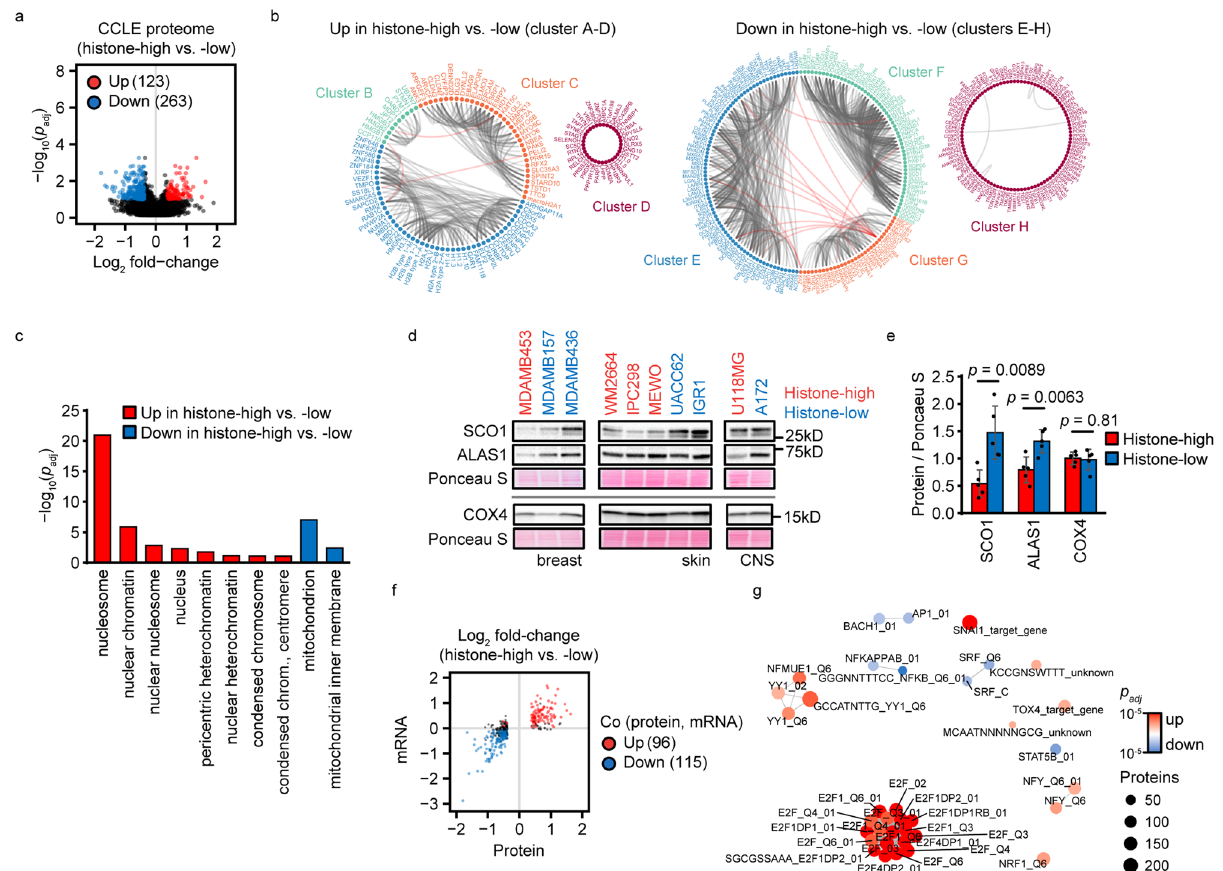
Fig. 4 Histone density-associated molecular signatures. a , b Signi fi cantly different proteins in histone-high ( N = 37) vs. -low ( N = 31) cells. a Proteins were tested for signi fi cantly different levels in histone-high vs. low cells using the R package maanova (FDR < 0.1, fold-change >1.3). Signi fi cant hits are shown in the Volcano plot by color coding. b Proteins with signi fi cantly higher or lower expression in histone-high cells were clustered by co-expression across cancer cell lines, and clusters were visualized by edge bundling. Grey and red edges represent co-expression within and between clusters, respectively. A magni fi cation of the panel is provided in Supplementary Fig. 5b. c GO slim cellular component analysis of differentially expressed proteins from ( a ). d , e Mitochondrial protein analysis by Western blot ( d ) and quanti fi cation based on lineage-centered protein levels normalized to Ponceau S staining of total proteins ( e ). Signi fi cance was analyzed with two-tailed Student ’ s t -test comparing the expression of the indicated proteins in histone-high ( N = 5) vs. -low ( N = 5) cell lines ± standard deviation. f Signi fi cantly different mRNAs in histone-high ( N = 37) vs. -low ( N = 31) cells. mRNAs encoding candidate proteins from ( a ) were tested for signi fi cantly different levels in histone-high vs. -low cells using the R package maanova (FDR < 0.1). Signi fi cant hits with co-regulation of protein and mRNA are shown in the scatter plot by color coding. g Transcription factor target gene set enrichment analysis of histone density-associated mRNAs. mRNA fold-changes in histone-high vs. -low cells ( f ) were subjected to gene set enrichment analysis using the transcription factor target signature collection. Signi fi cant signatures (FDR < 0.1) were clustered and visualized by emapplot (R package clusterpro fi ler). The node color indicates the direction of signature